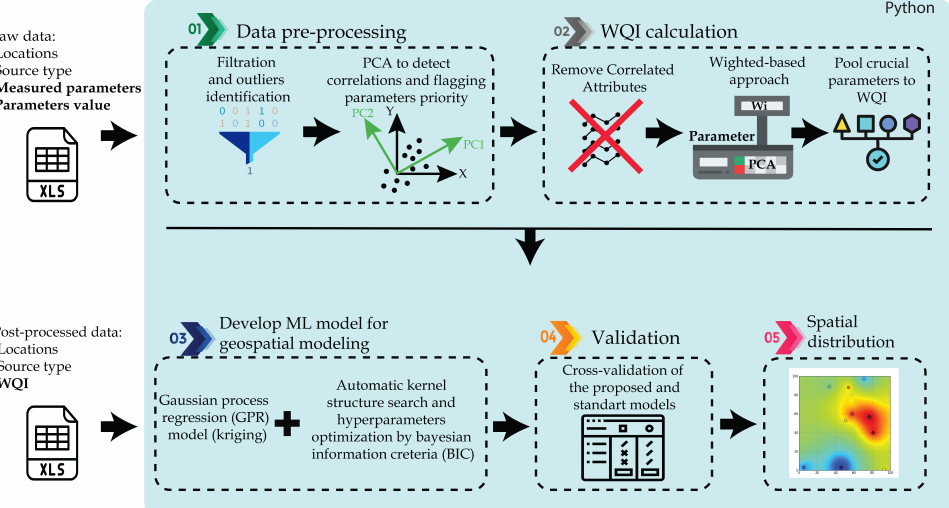
Figure 2. Our approach use machine learning methods for weighted WQI calculation (Steps 1 and 2) and geospatial WQI prediction by using Gaussian process regression with automatic kernel search (Steps